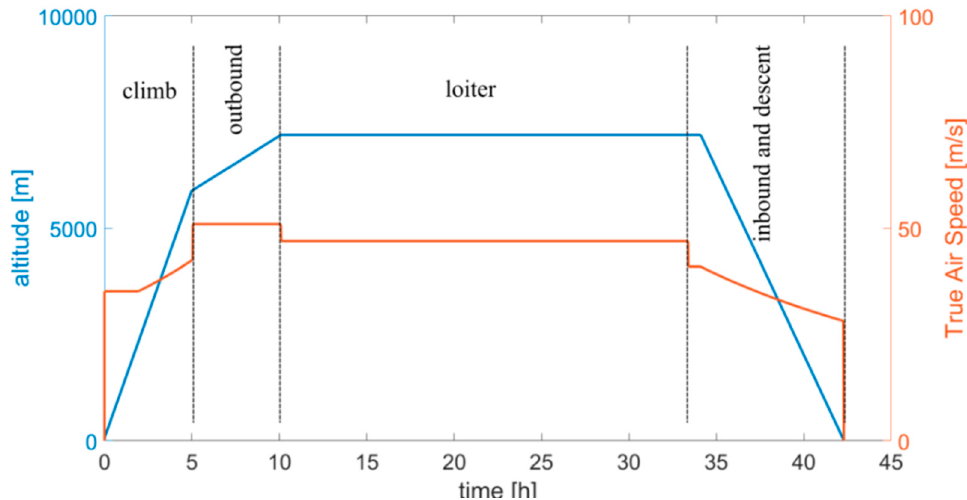
Figure 9. Baseline mission profile for the MALE-UAV.